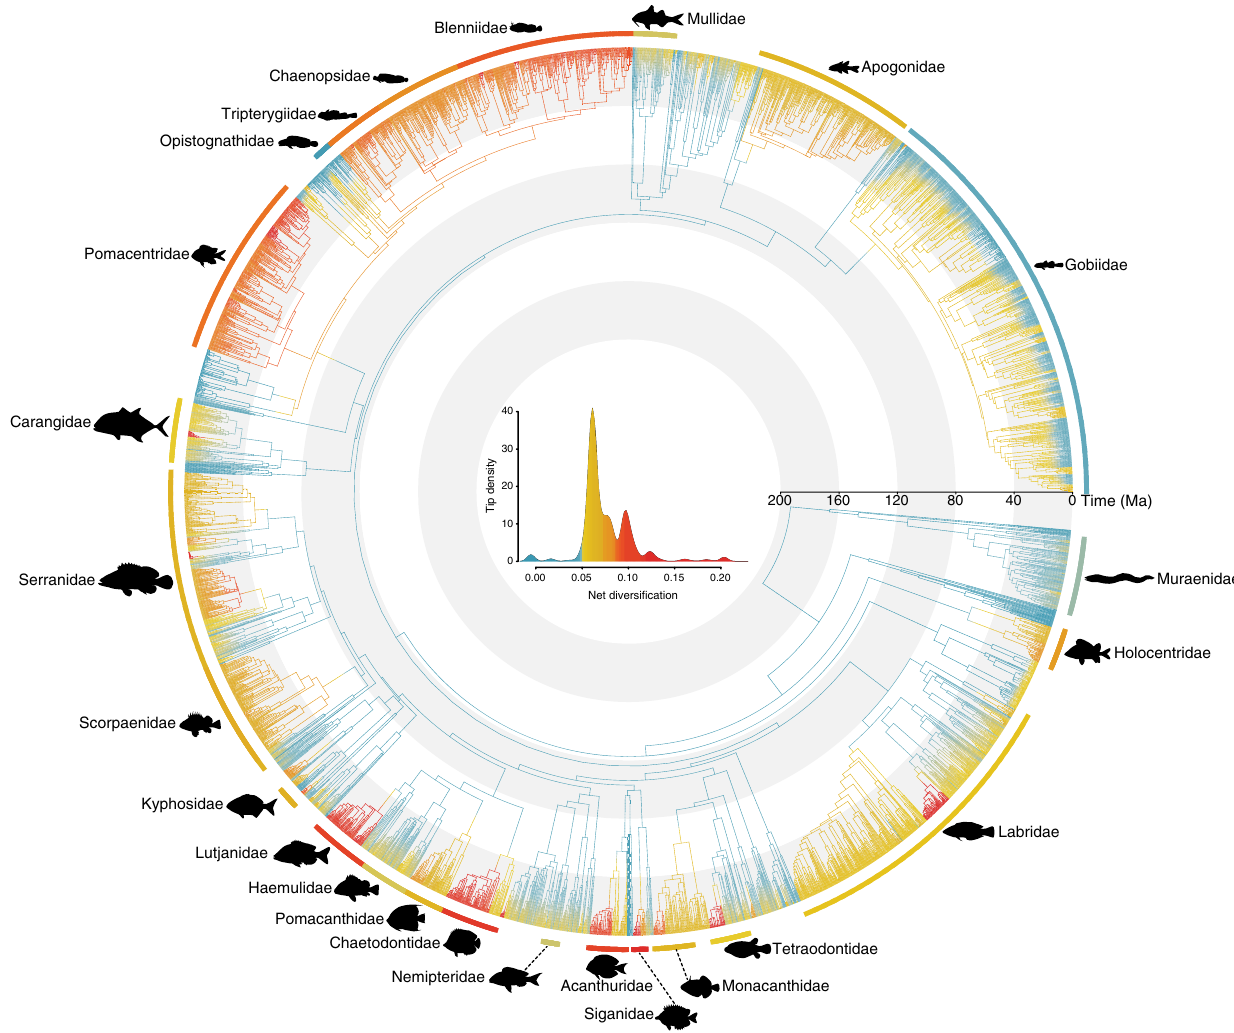
Fig. 1 Near-complete reef fi sh phylogeny mapped with net diversi fi cation rates. Inset shows the overall distribution of diversi fi cation rate values for all tree tips. Blue colors represent low diversi fi cation rates, yellow intermediate, and red colors depict high diversi fi cation values. Rates were estimated through BAMM 69 . External arcs show median diversi fi cation rates estimated for some iconic reef fi sh families, represented by the silhouettes (sourced from Schiettekatte et al. 91